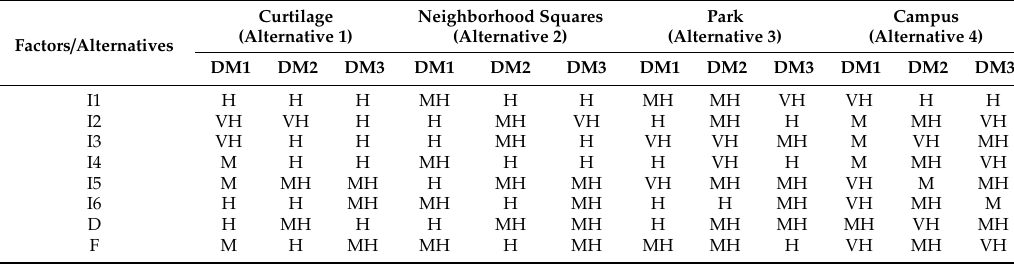
Table A10. Linguistic evaluations of